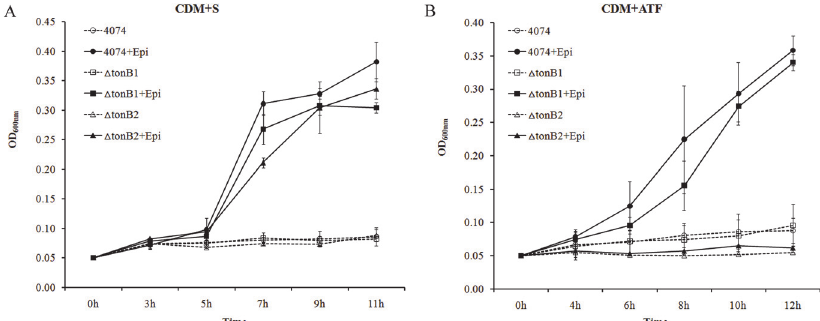
Fig 5. The effects of catecholamines on growth of A . pleuropneumoniae Δ tonB1 and Δ tonB2 mutants. A . pleuropneumoniae was cultured in TSB medium overnight and then sub-cultured into CDM using an inoculation dose of 10 4 CFU/ml. A . pleuropneumoniae 4074 and the mutants were sub-cultured in CDM containing 50 μ M of Epi and 1/40 of serum (S in figure A) or 400 μ g/ml ATF (figure B). Optical densities of bacterial cultures (OD 600nm ) were recorded at selected time points. Data are shown as means ± SD from four independent